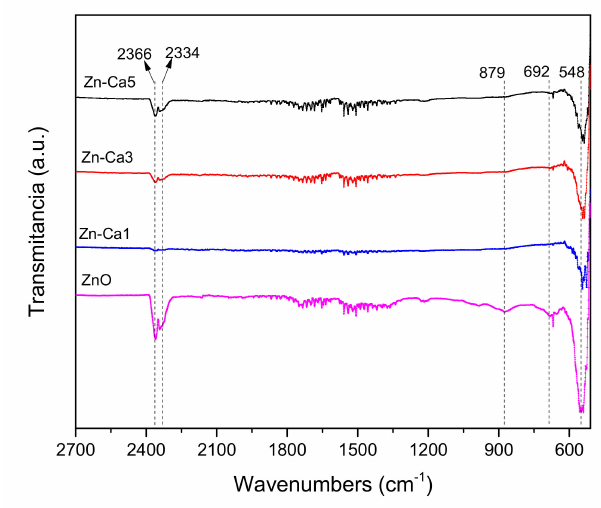
Figure 4. FT − IR spectra of Zn-Ca